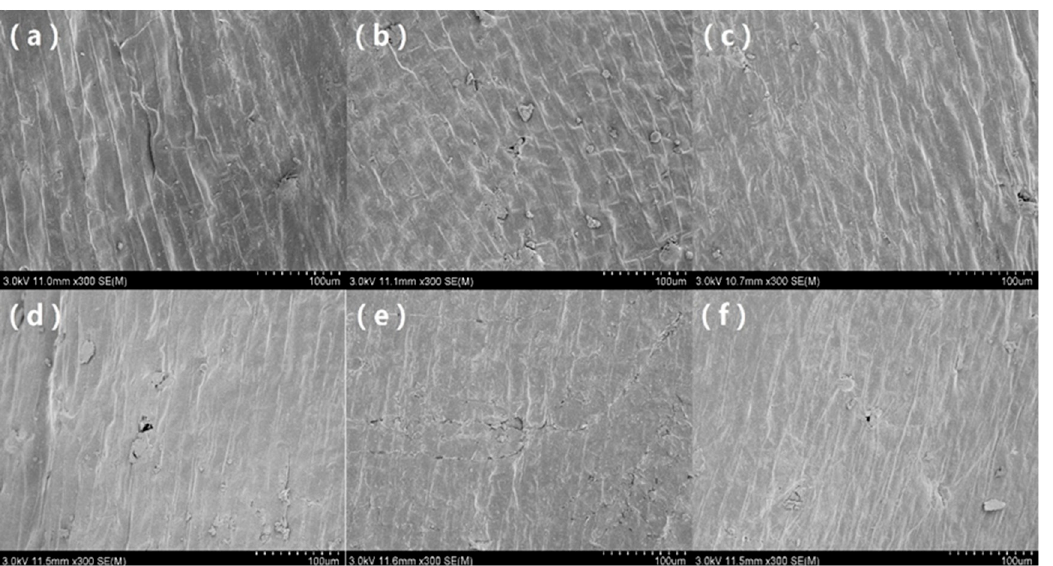
Figure 8. Scanning electron microscope (SEM) photos of naked oat seeds under HVEF treatment with x300 magnification. ( a ) CK; ( b ) 8 kV; ( c ) 8 kV + covered; ( d ) 16 kV; ( e ) 20 kV; ( f ) 20 kV + covered.